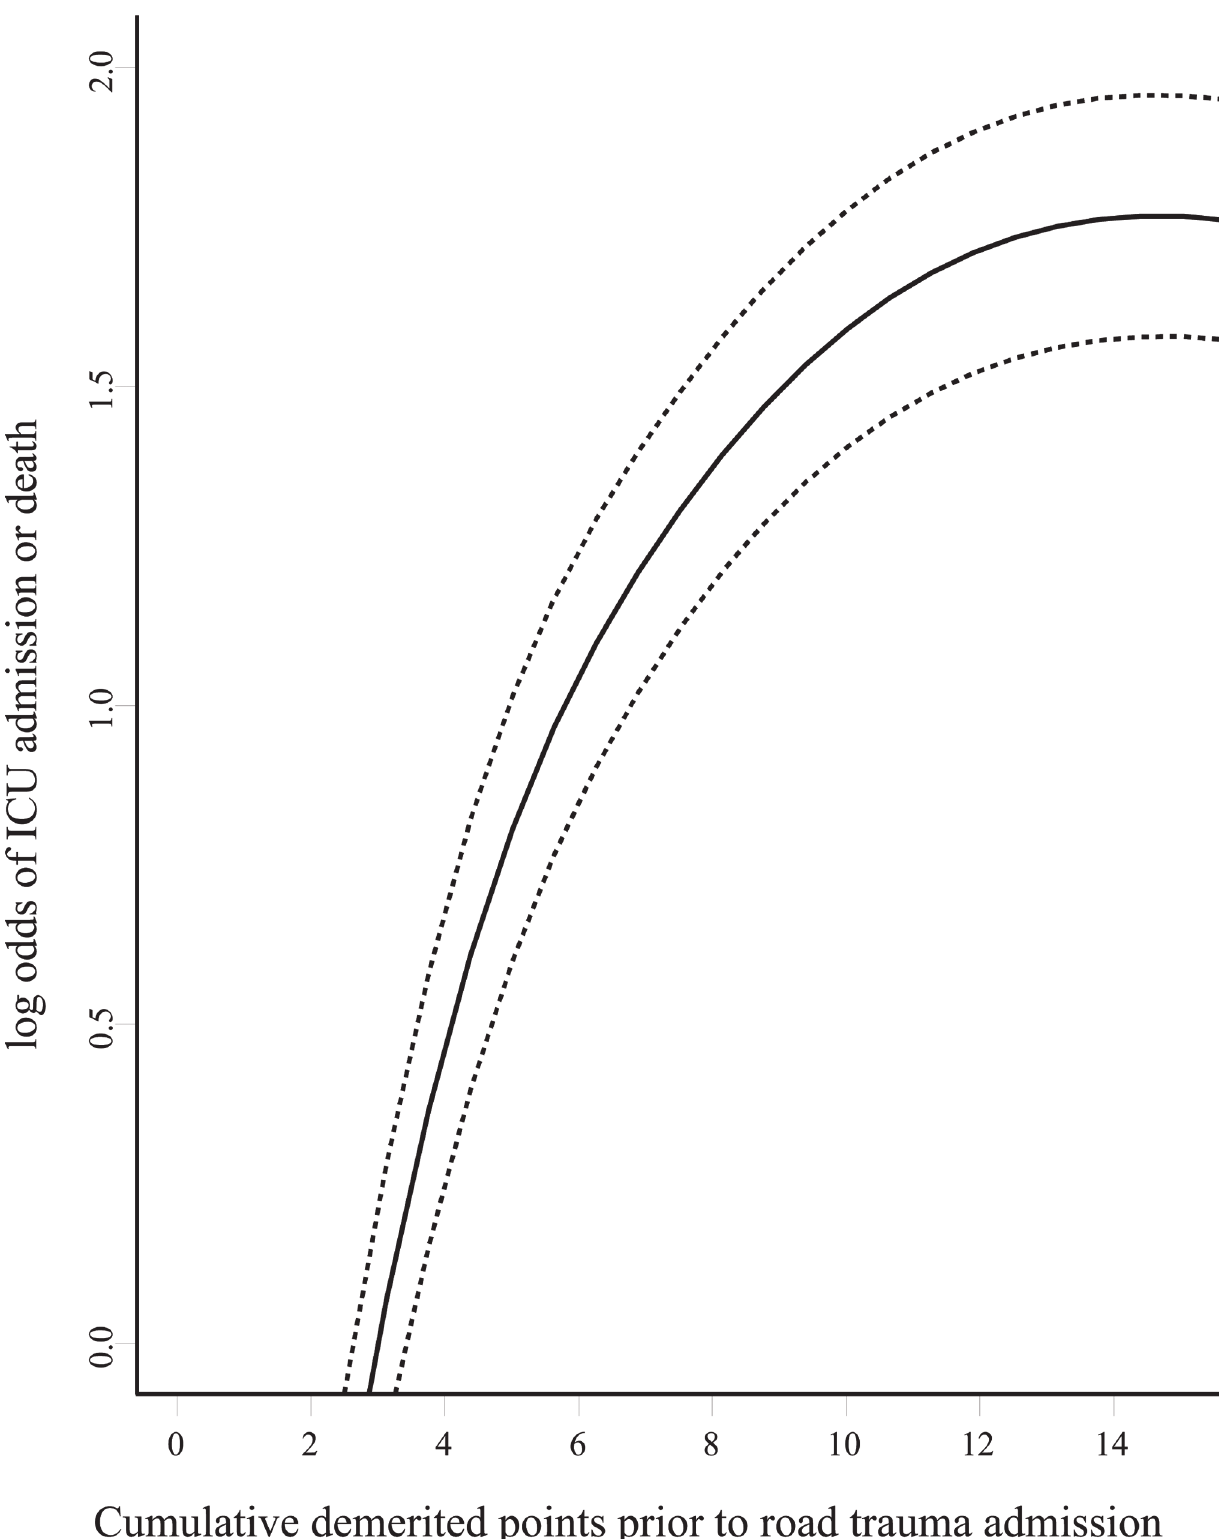
Fig 2. Relationship between cumulative traffic offences demerit points and risk of requiring intensive care unit (ICU) admission or death from road trauma. Dotted lines delineate 95% confidence interval. doi:10.1371/journal.pone.0122652.g002 PLOS ONE | DOI:10.1371/journal.pone.0122652 April 22,